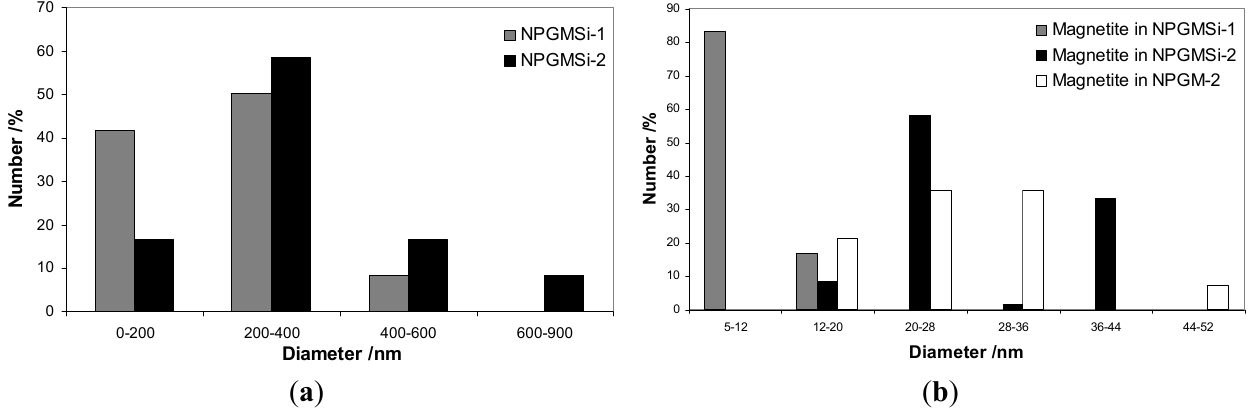
Figure 2. Size distribution of: ( a ) NPGMSi-1 and NPGMSi-2 nanocomposites; and ( b ) iron oxide colloids within NPGMSi-1, NPGM-2 and NPGMSi-2 nanocomposites from TEM